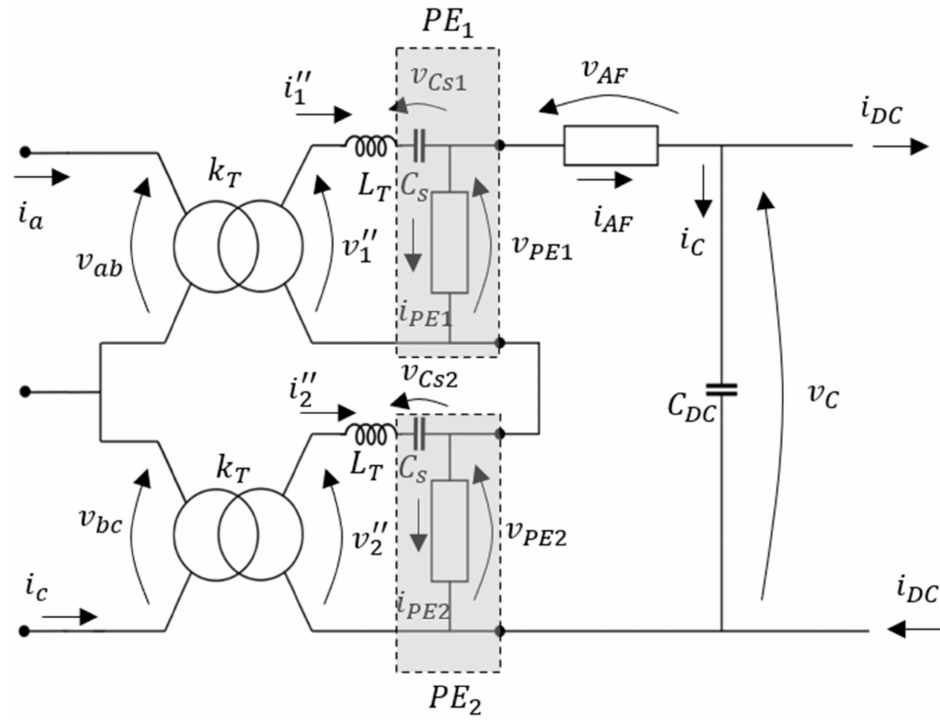
Figure 7. Open-delta CLSC